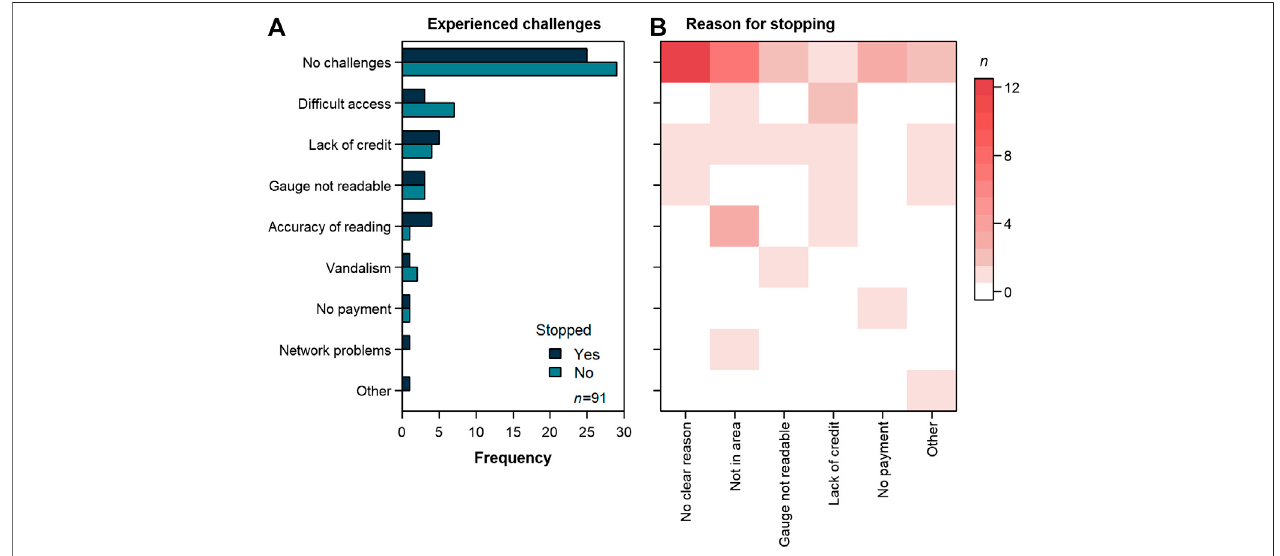
FIGURE 5 | Respondents ’ answers regarding (A) type of challenges experienced, classi fi ed by whether the respondent indicated to have stopped participating, and (B) reason stated for stopping participation, grouped by challenge. n (cid:2) number of responses.